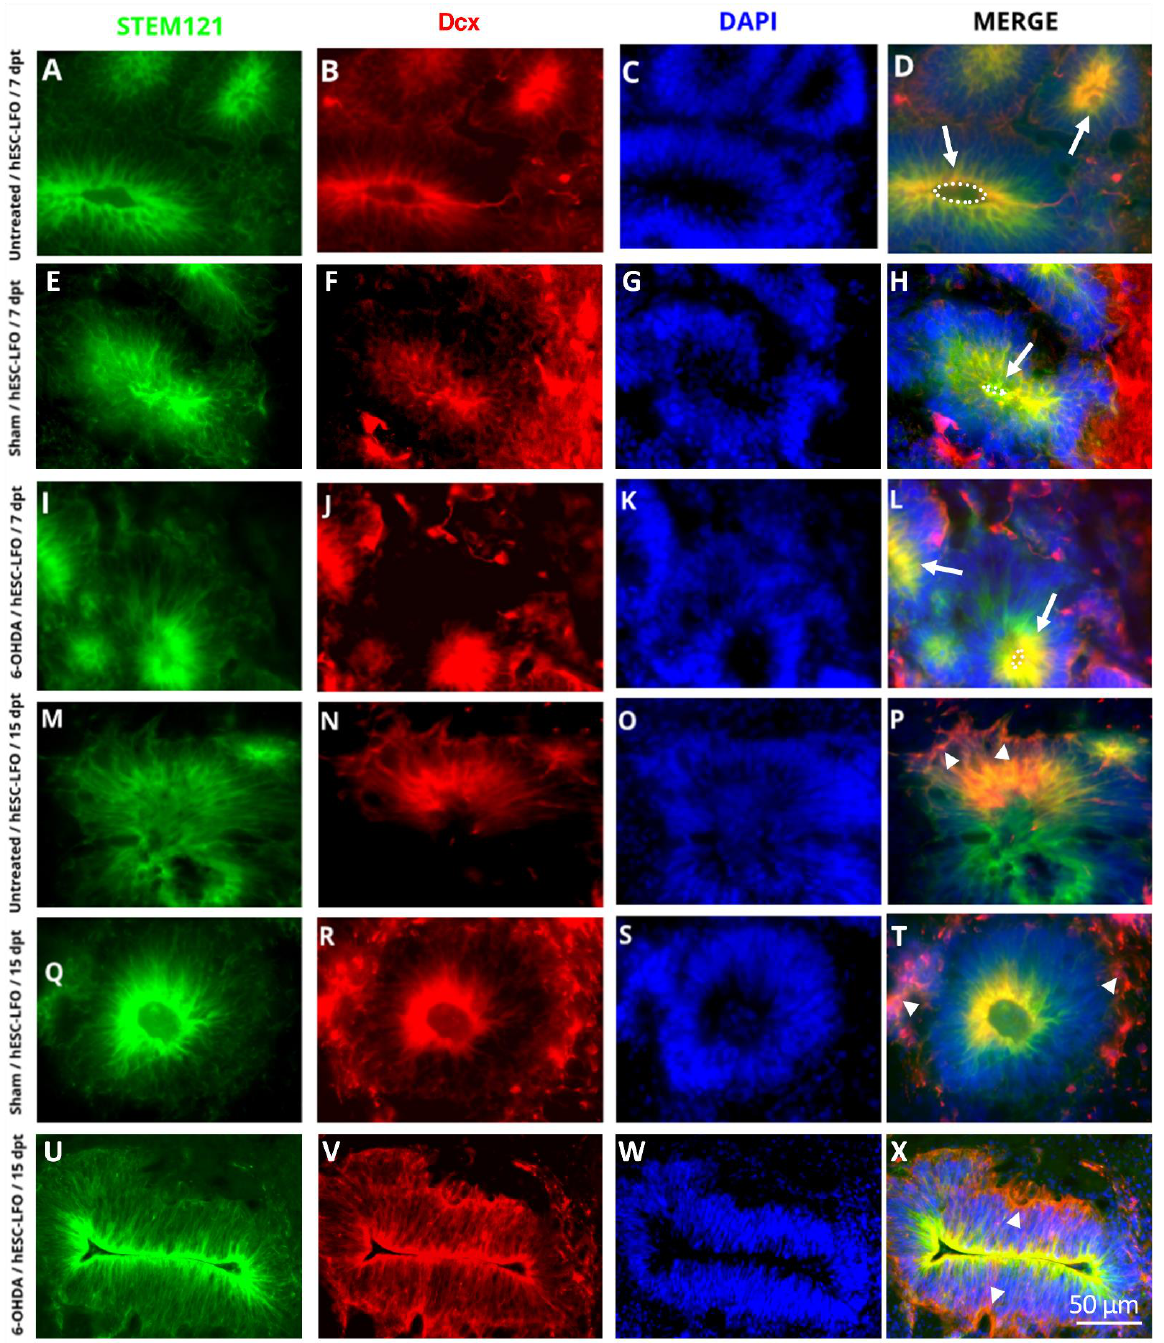
Figure 5. Neural rosettes of grafted hESC-LFO EBCs expressed Dcx at 7- and 15-days post- transplantation in the substantia nigra pars compacta. Representative images of neural rosettes from the hESC-LFO EBCs grafts expressing Dcx. Neural rosettes cytoplasm was marked with the human cell antibody STEM121 (green). Dcx signal (red) was mainly present in the lumen area of the neural rosettes at ( B , F , J ) 7 dpt, whereas at ( N , R , V ) 15 dpt it was more prevalent in the periphery of the neural rosettes. DAPI was used to stain cell nuclei (blue). Transplanted tissue corresponds to ( A – D , M – P ) untreated, ( E – H , Q – T ), sham, and ( I – L , U – X ) 6-OHDA at ( A – L ) 7 and ( M – X ) 15 dpt. White arrows in ( D , H , L ) indicate Dcx signals in the lumen of neural rosettes. Dotted ellipses in ( D , H , L ) indicate the apical zone. Arrow heads in ( P , T , X ) indicate Dcx signals surrounding the neural rosettes. dpt: days post-transplantation; Dcx: doublecortin.